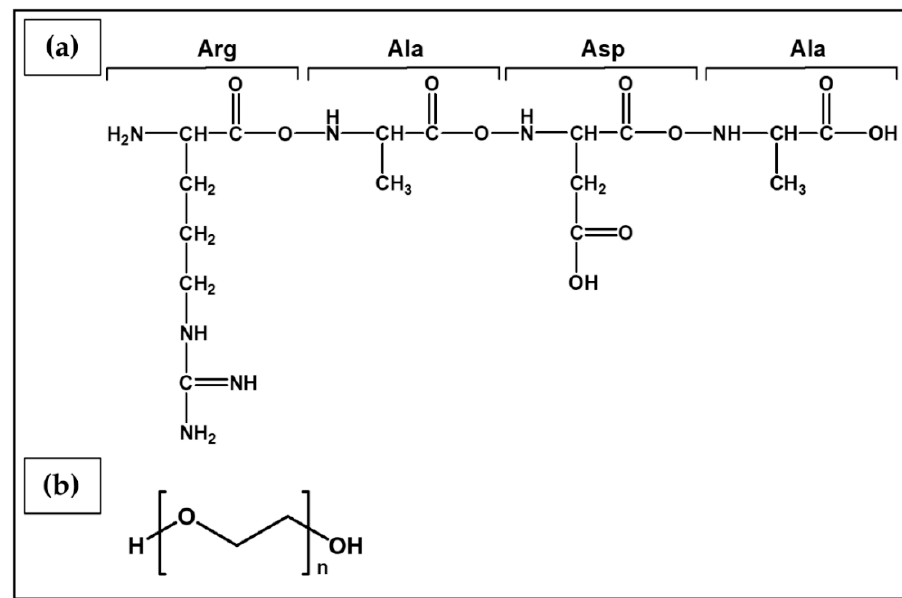
Figure 14. Chemical structure of synthetic polymers employed in hydrogel-based scaffolds for in vitro OC modeling. ( a ) Tetrapeptide sequence found in RIPA16-I peptide, and ( b ) poly(ethylene glycol) (PEG).